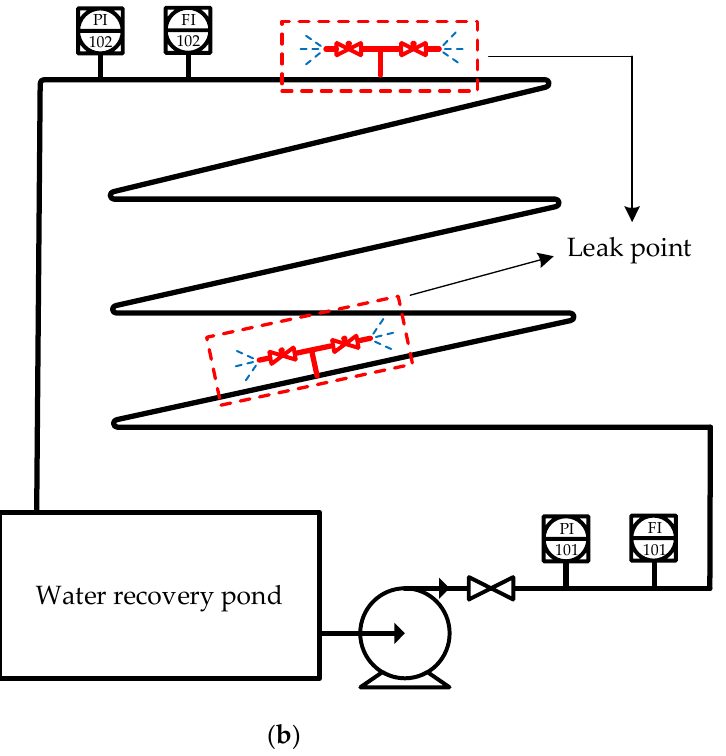
Figure 3. Experimental device. ( a ) Photo of experimental setup and components; ( b ) schematic diagram of experimental setup.